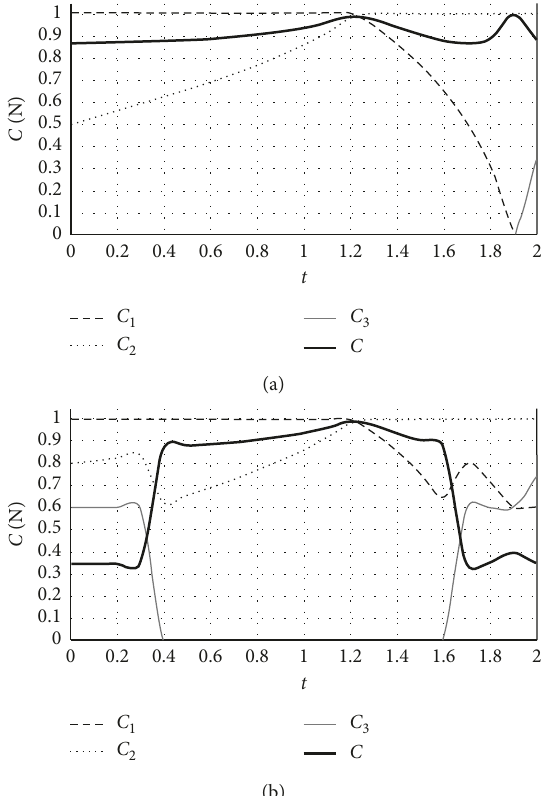
Figure 10: Graph of calculated equivalent contact forces when rotation of the sphere is simulated. (a) C ∈ [ 0 , 1 ] N. (b) C ∈ [ 0 . 6 , 1 ]